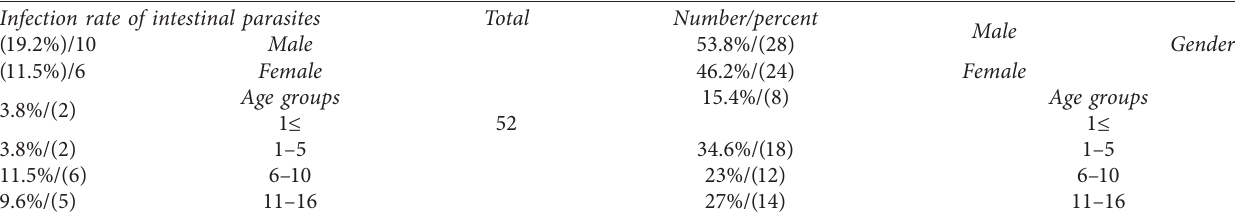
Table 1: Demographic specification of patients and infection rate of intestinal parasites in cancerous children.